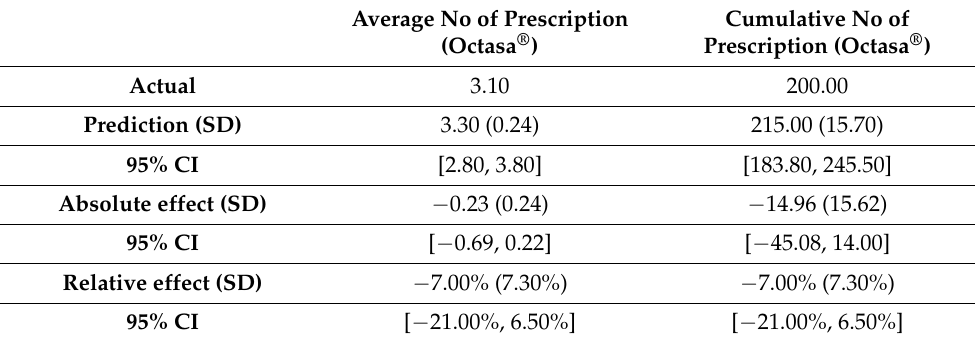
Table 4. Summary statistics—Causal Impact Analysis (post-intervention 1 vs. post intervention 2) for Octasa ® .